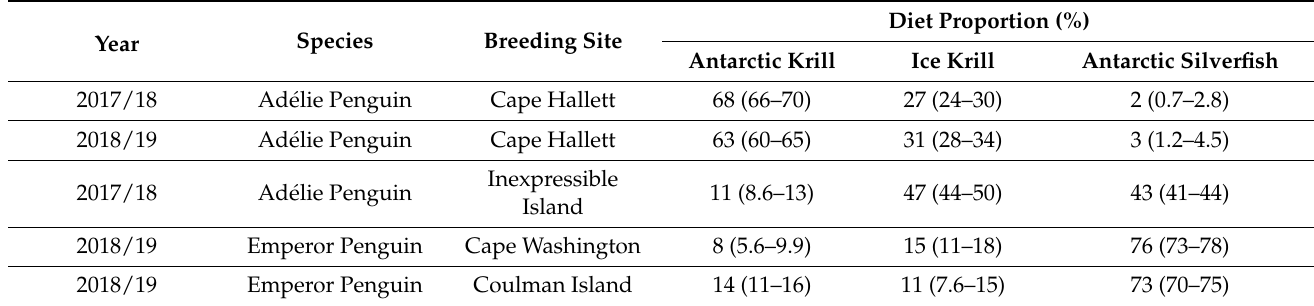
Table 2. Diet composition of Ad é lie and Emperor penguin chicks based on the SIAR model. Values are presented as the mean estimates with 95% credibility